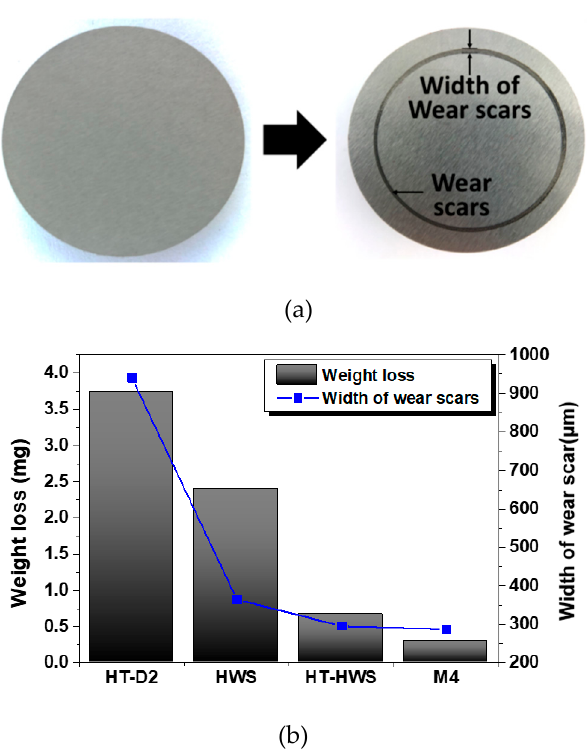
Figure 8. ( a ) Images of wear scars after the ball-on-disc wear test, and ( b ) comparison of weight loss and wear